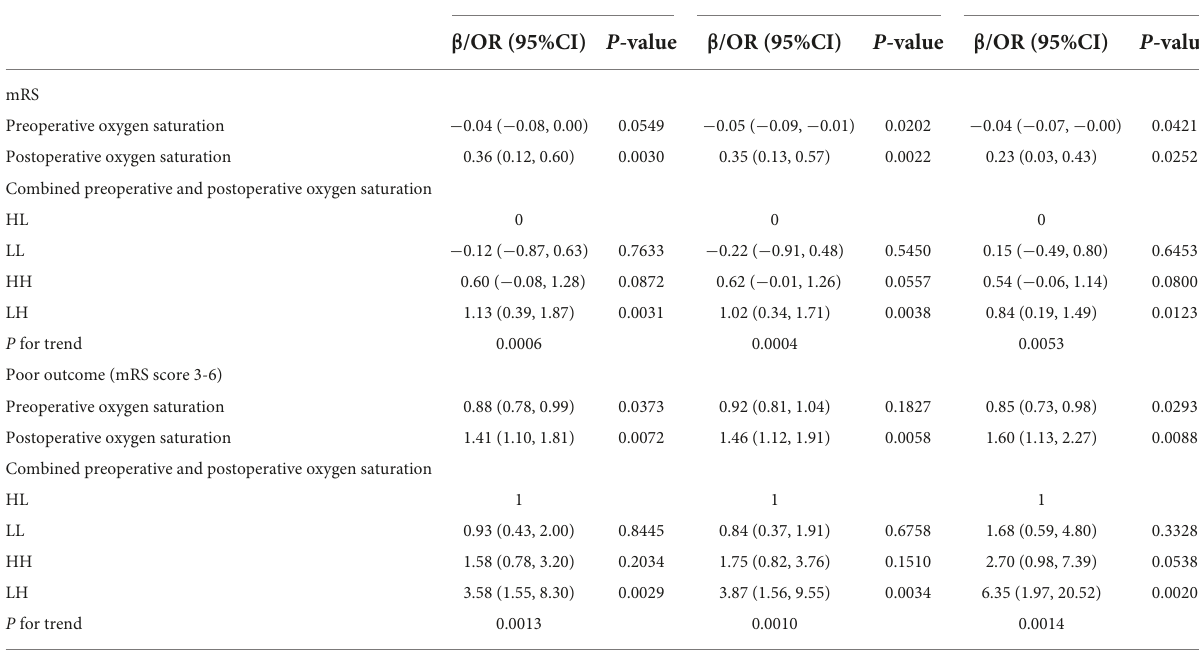
TABLE 2 Relationship between preoperative, postoperative, or combined oxygen saturation and functional outcomes among patients with acute ischemic stroke in different models. Variable